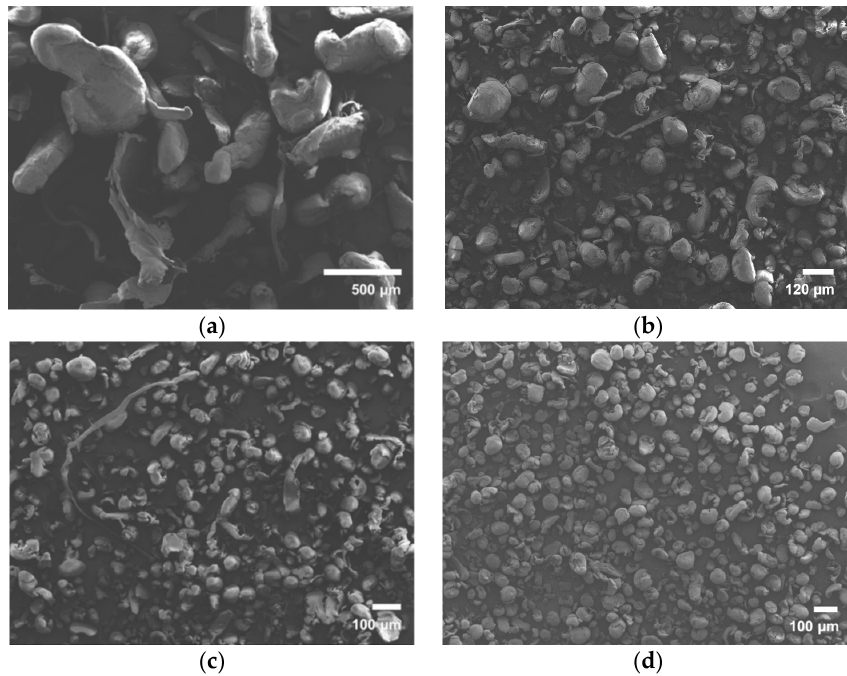
Figure 3. SEM micrographs of the multiple steps of the rotor-milling process. ( a ) Coarse powder by milling sPS pellets at 500 µm; ( b ) first refinement step by milling at 120 µm; ( c ) second refinement step by milling at 80 µm; ( d ) final powder after an additional sieving step at 80 µm.